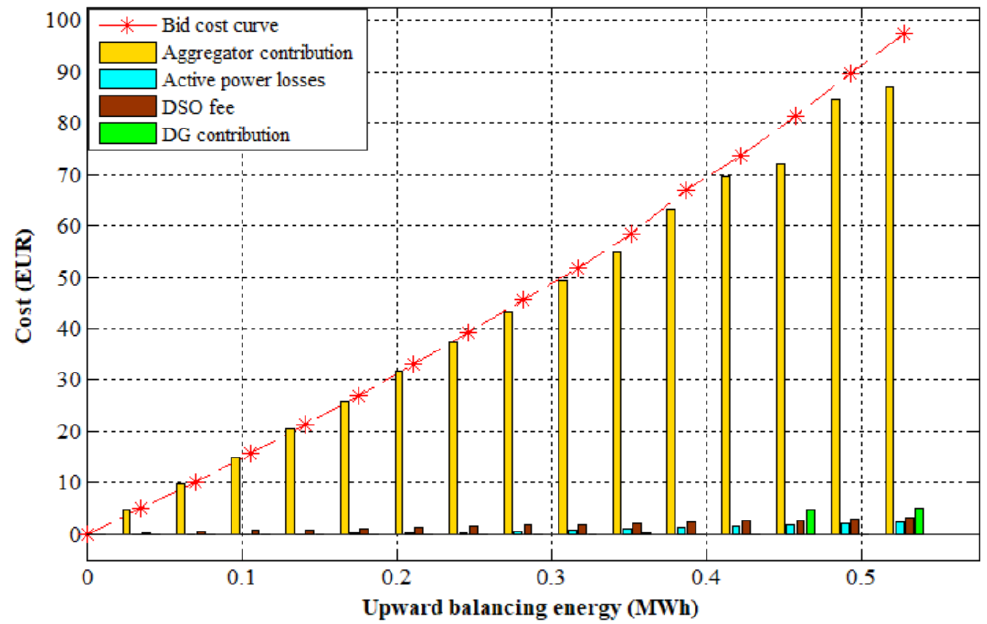
Figure 5. Aggregated price/quantity curve as a function of upward balancing energy.